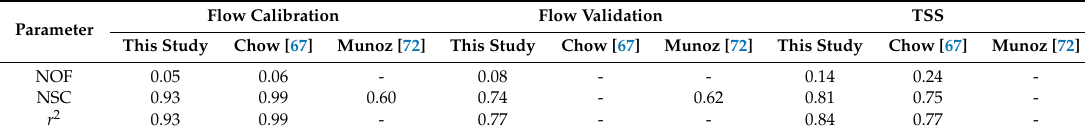
Table 5. Comparison of the results of goodness-of-fit test with previous